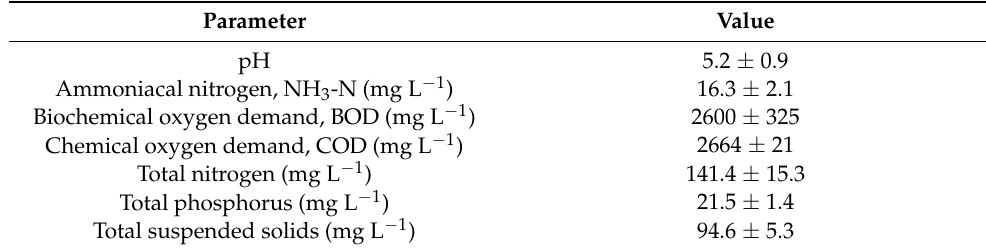
Table 1. Physicochemical characteristics of POME a